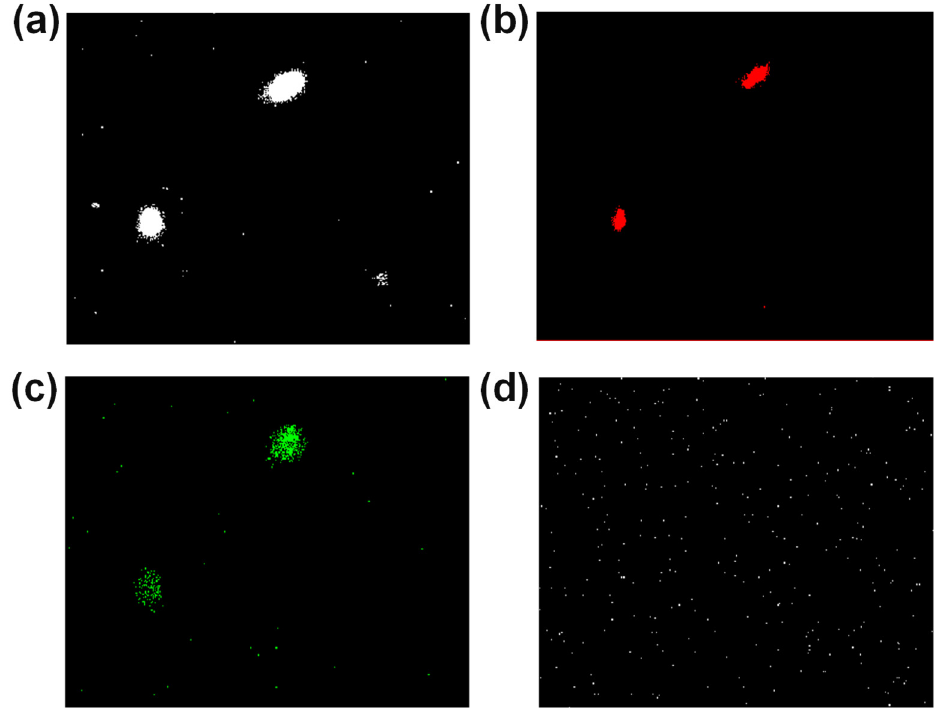
Figure 3. Confocal images of FeAu in different filters under 515 nm laser. ( a ) Null, ( b ) 600 ± 37 nm, ( c ) 530 ± 43 nm, ( d ) 440 ± 40 nm.